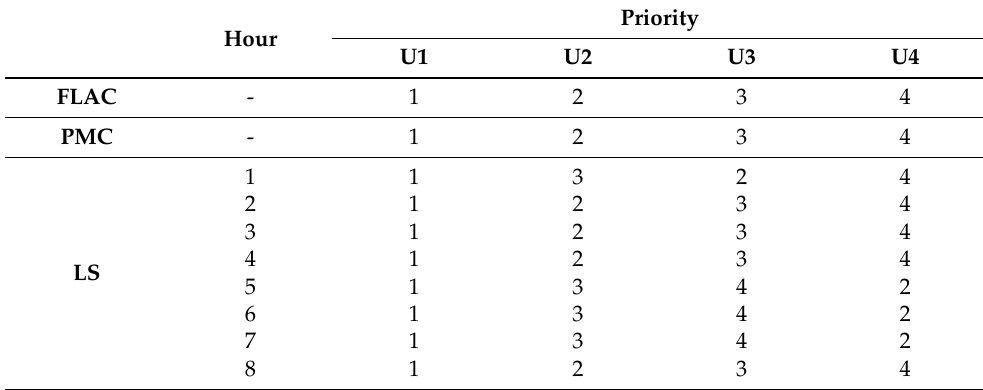
Table 1. Initial priority lists based on the chosen